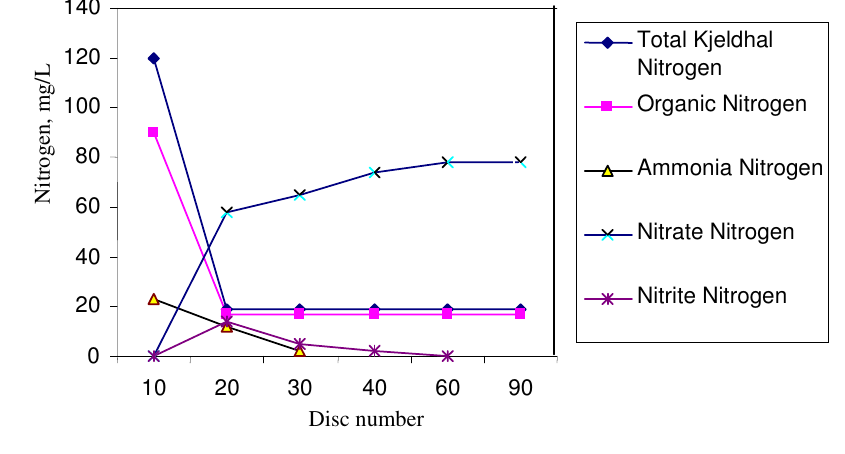
Figure 5. Nitrification